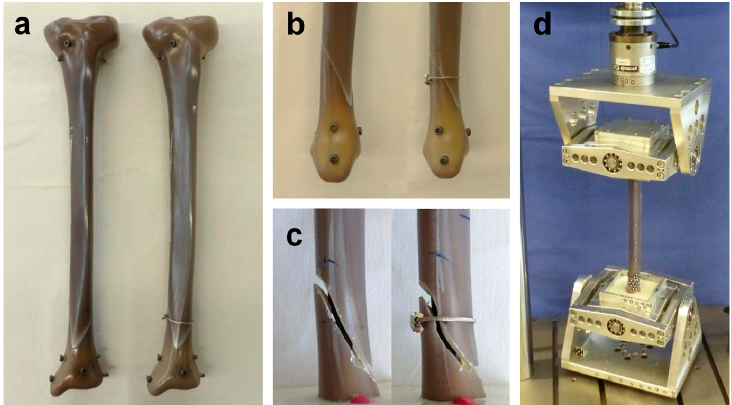
Figure 1. Synthetic tibia sample and test setup: ( a ) frontal view on the instrumented tibia with the solitary nail and with supplemental cable cerclage wiring around the fracture zone; ( b ) medial view on the distal tibia with a reduced fracture gap; ( c ) 5 mm fracture gap; ( d ) test setup with two cardan joints to avoid constraining forces.